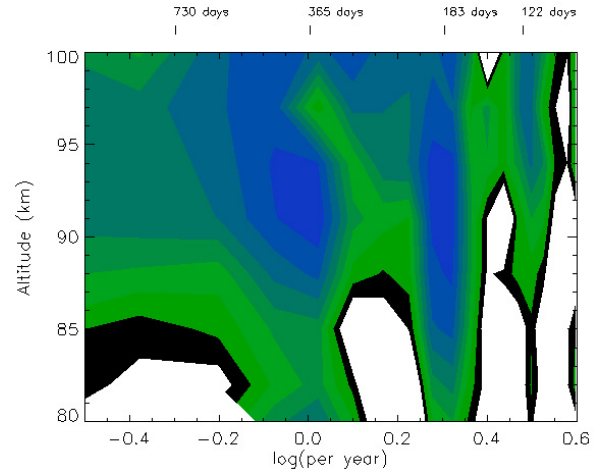
Fig. 3. One-dimensional power spectra from the data in Fig. 1. Ab- solute values are omitted to maintain clarity. Here the high fre- quency part of the spectra are shown. The abscissa indicates fre- quency in units of day − 1 , again, selected corresponding periods in days are indicated in the upper part of the panel. Contours show power spectral density in arbitrary units, the absolute values of which may be obtained from Fig. 6.